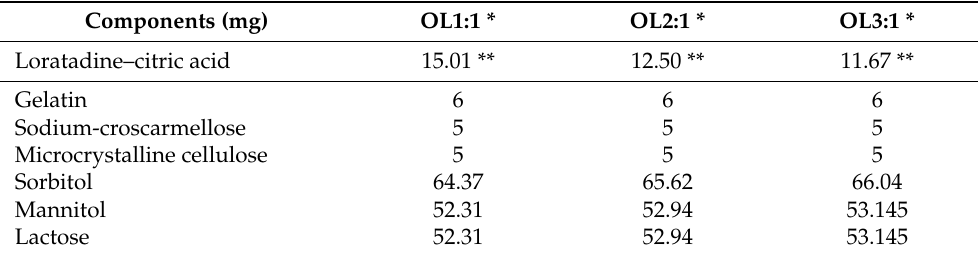
Table 2. ODx composition prepared by